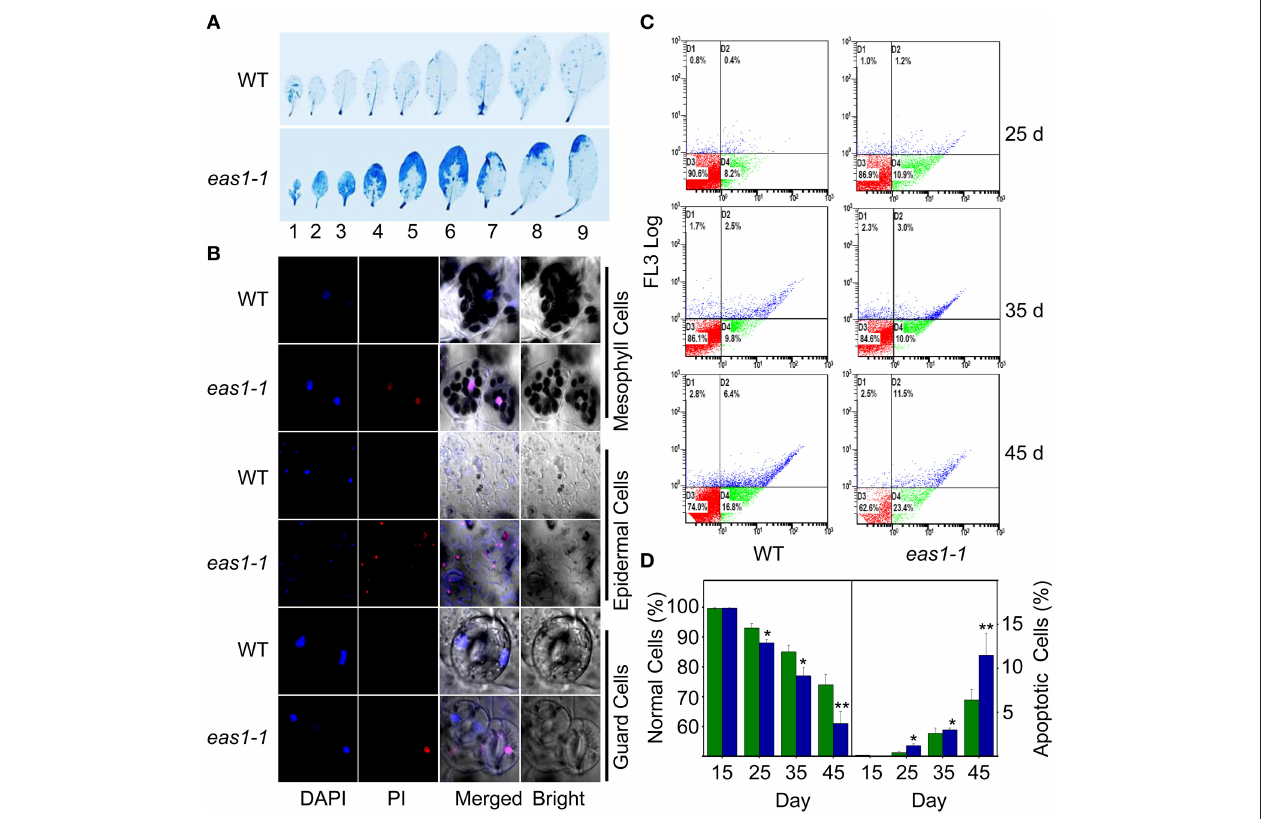
FIGURE 4 | EAS1 mutation causes earlier apoptosis in leaves of eas1-1 mutant plants than in wild-type plants. (A) The first to ninth true leaves of wild-type and eas1-1 mutant plants at 35 days after sowing under unstressed condition in soil. Leaves were stained with trypan blue for the detection of dead cells. (B) Estimation of cell membrane integrity by PI staining using confocal images. The sixth leaves of wild-type and eas1-1 mutant plants at 35 days after sowing were used to isolate mesophyll cells, epidermal cells, and guard cells under unstressed condition in soil. Cells were subjected to 10 µ M DAPI and 10 µ g/mL PI staining for 0.5h. (C) Quantification of age-dependent cell apoptosis by flow cytometry. Mesophyll protoplasts of sixth leaves were counted by cytometry in wild-type and eas1-1 mutant plants at 25, 35, and 45 days after sowing under unstressed condition in soil. Cell counts in the four regions D1, D2, D3, and D4 represent the proportions of late-senescent cells, apoptotic cells, normal cells, and early-senescent cells, respectively. (D) Normal and apoptotic cell percentages of wild-type and eas1 mutant protoplasts. The ratio of normal and apoptopic cells were the average of 15 results from three independent experiments. CXP ACQUISITION and CXP ANALYSIS software packages (Beckman-Coulter) were used for data acquisition and analysis, respectively. Bars indicate standard errors, while asterisks indicate significant differences from wild-type plants under Student’s test ( * p < 0.05 , ** p < 0.01